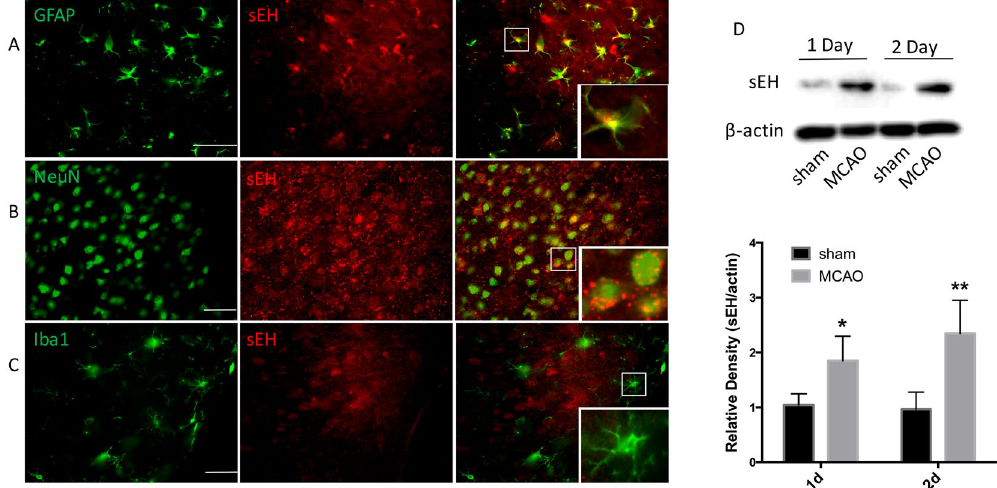
Figure 1. Localization of sEH in rat brain and its expression after ischemia. Representative images show double immunofluorescent staining of sEH (red), GFAP ( A , green), NeuN ( B , green), and Iba1 ( C , green) in cerebral cortex under normal conditions. Scale bar = 50 μ m for low power images. Area in white square is shown in inset at higher power. ( D , E ) Western blot of sEH expression on 1 and 2 days after reperfusion in the area around the ischemic lesion. The sEH and β -actin bands were stripped and cropped from the same gel and were developed with the same exposure. Images of the full gel are shown in Supplementary Figure S1. Comparisons between sham and MCAO groups were made by t -test (means ± SD; n = 5 rats per group; * p < 0.05, ** p < 0.01 vs sham